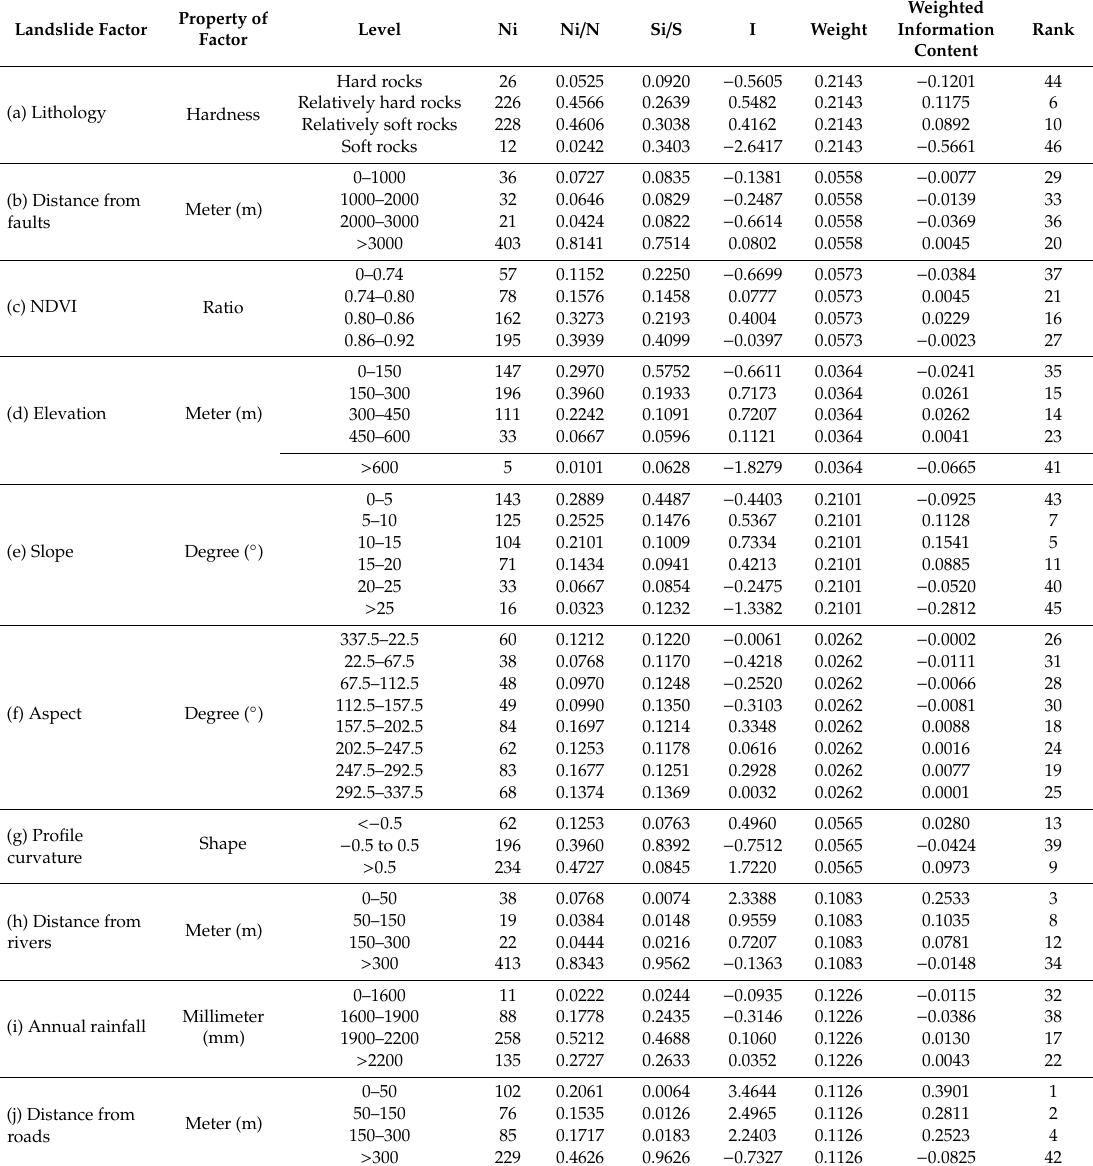
Weighted Information Content